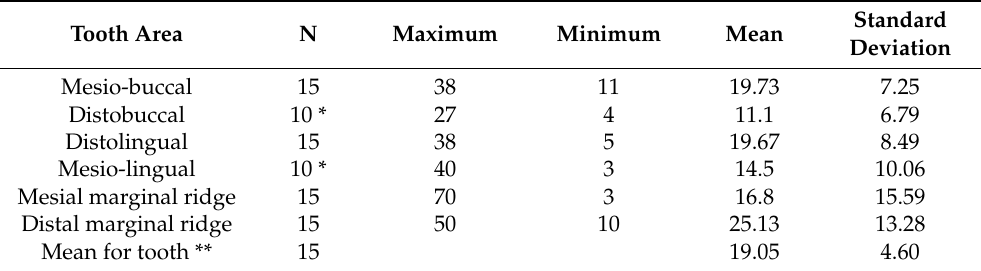
Table 2. Occlusal vertical discrepancies ( µ m) of crowns in resin-modified glass ionomer cement (RMGIC) group measured at 6 points in each tooth.